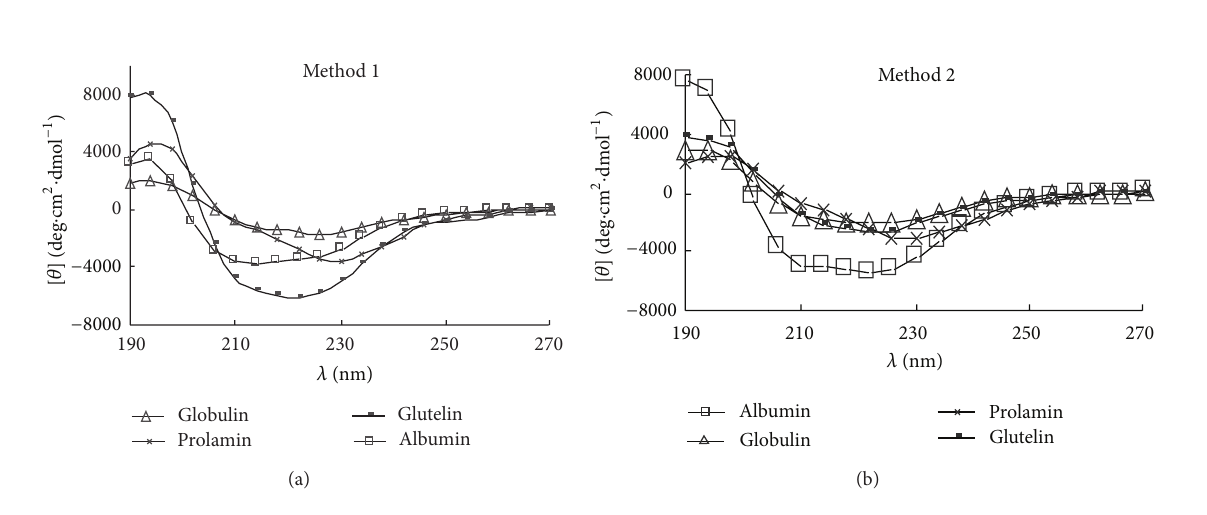
Figure 8: CD spectra of FRBPs prepared by the two extraction